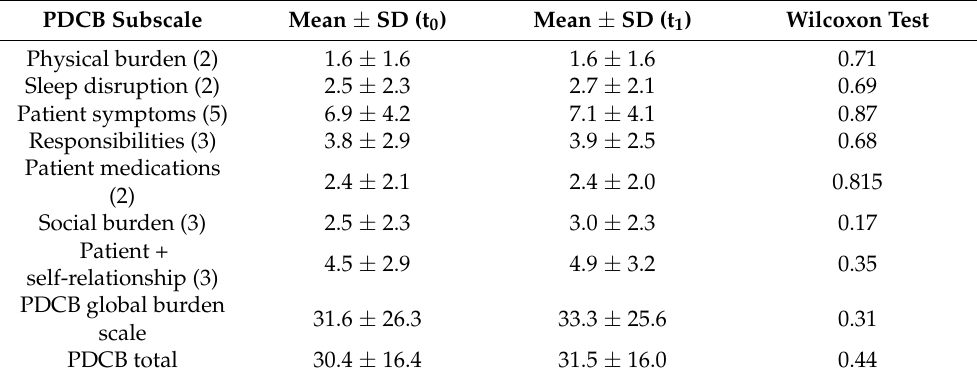
Table 2. Longitudinal course of the “Parkinson’s disease caregiver burden” questionnaire (PDCB)